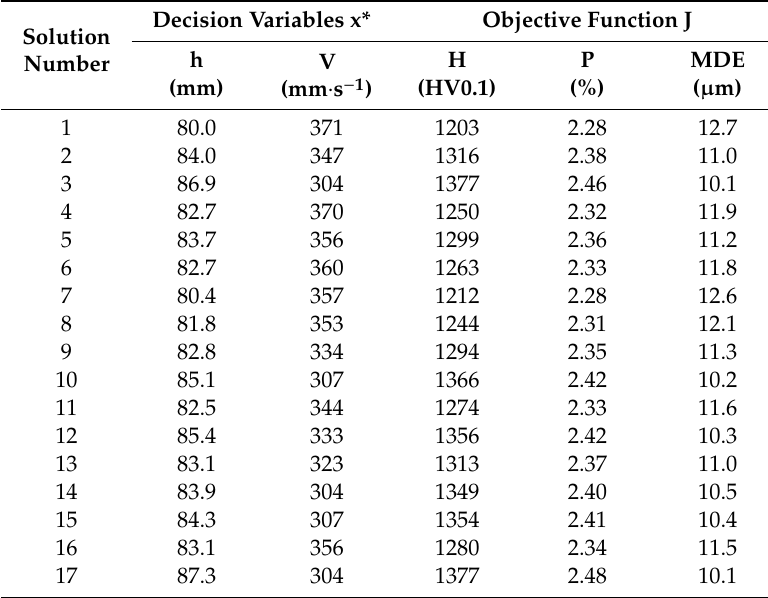
Table 4. Set of Pareto-optimal